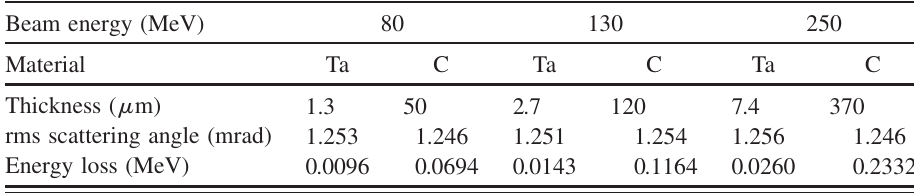
TABLE II. Thickness of the primary momentum collimators at different